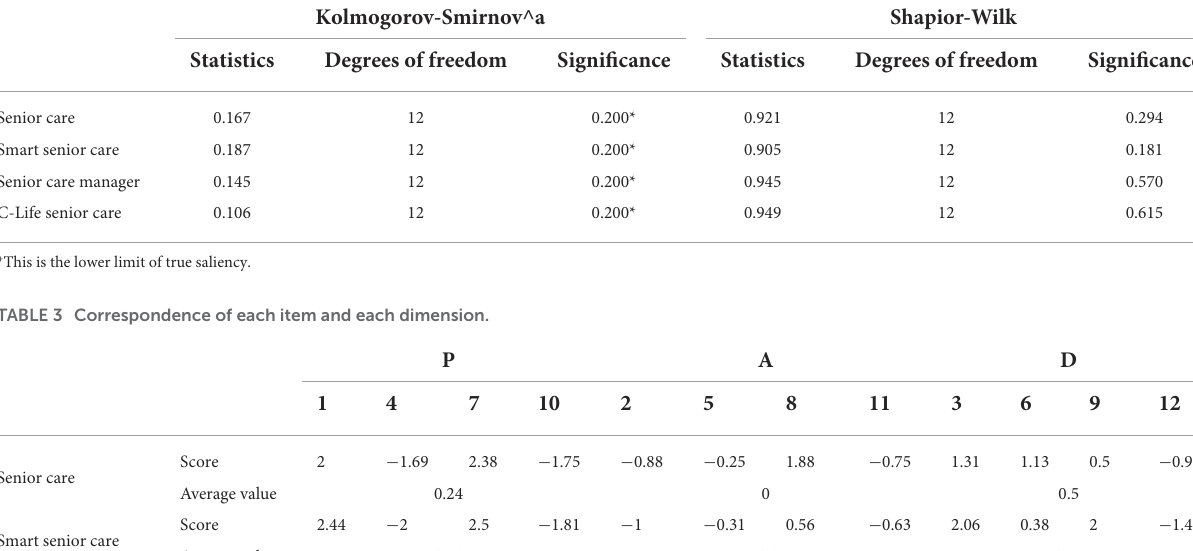
TABLE 2 Normal distribution of the PAD scale of the four products.